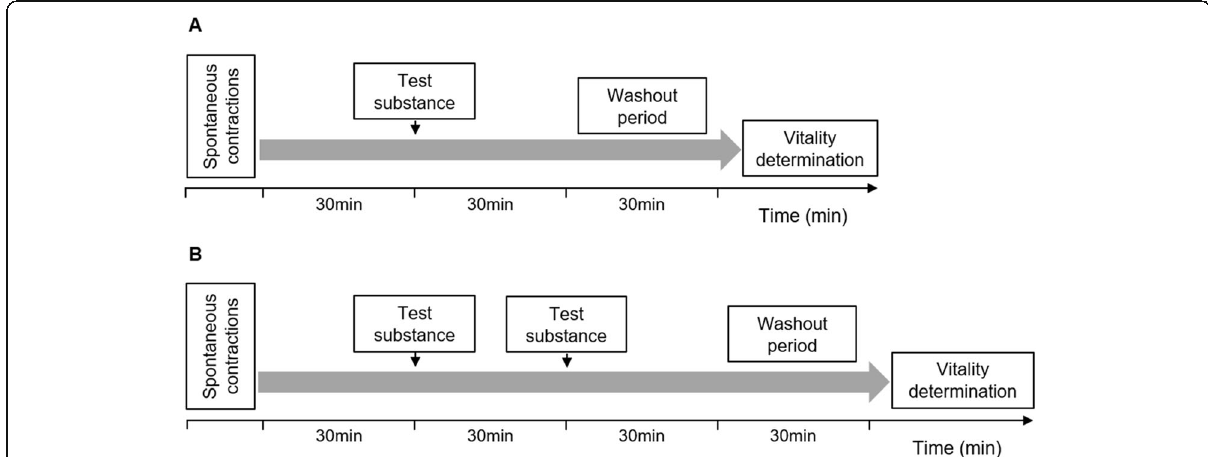
Fig. 1 Experimental design for measurement of myometrial contractions. Test substances were added to the organ bath when myometrium strips had been contracting regularly for 30 min. When the effects of BPJ and/or atosiban were being studied ( a ) , Krebs solution (control), BPJ, atosiban, or the combination of BPJ and atosiban were added, and contractility was recorded for 30 min. When the effects of BPJ and/or nifedipine were being studied ( b ) , Krebs solution (control; two strips) or nifedipine (two strips) was added, contractility was recorded for 30 min, and then BPJ was added to all chambers. Exposure to test substances was followed by a 30 min washout step, with change of Krebs solution at 5, 10, 20 and 30